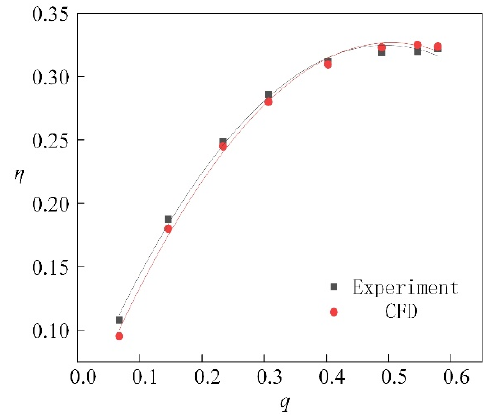
Figure 3. Experiment and simulation data. CFD: computational fluid dynamics.